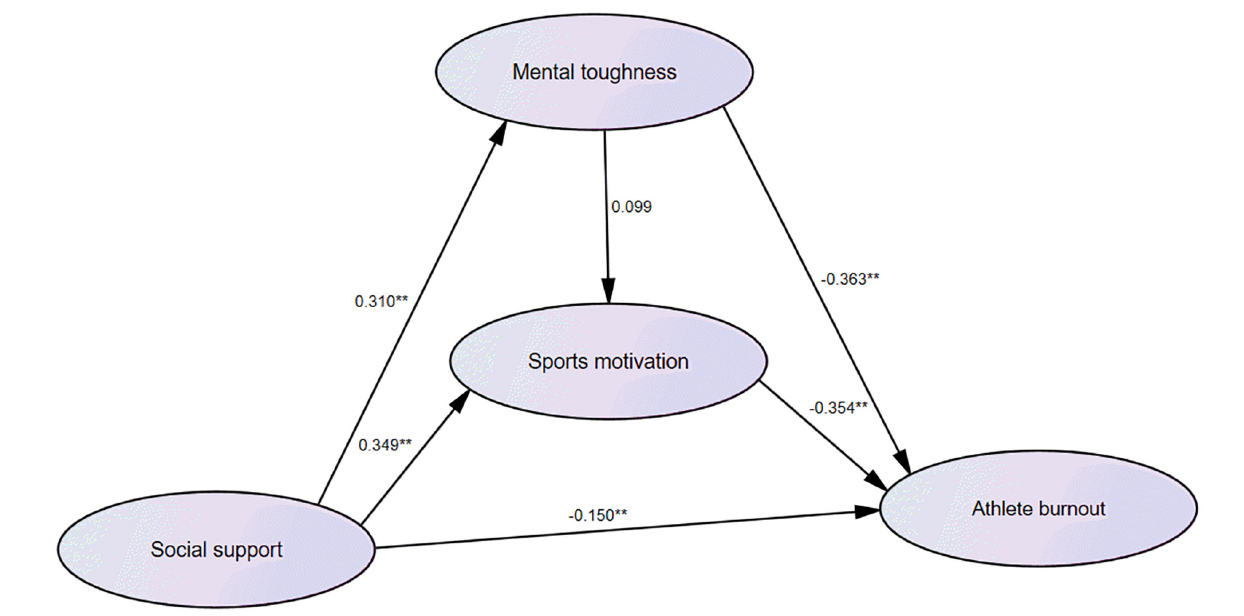
FIGURE 1 | Schematic diagram of path analysis of social support, sports motivation, mental toughness, and athlete burnout. **P < 0.01.